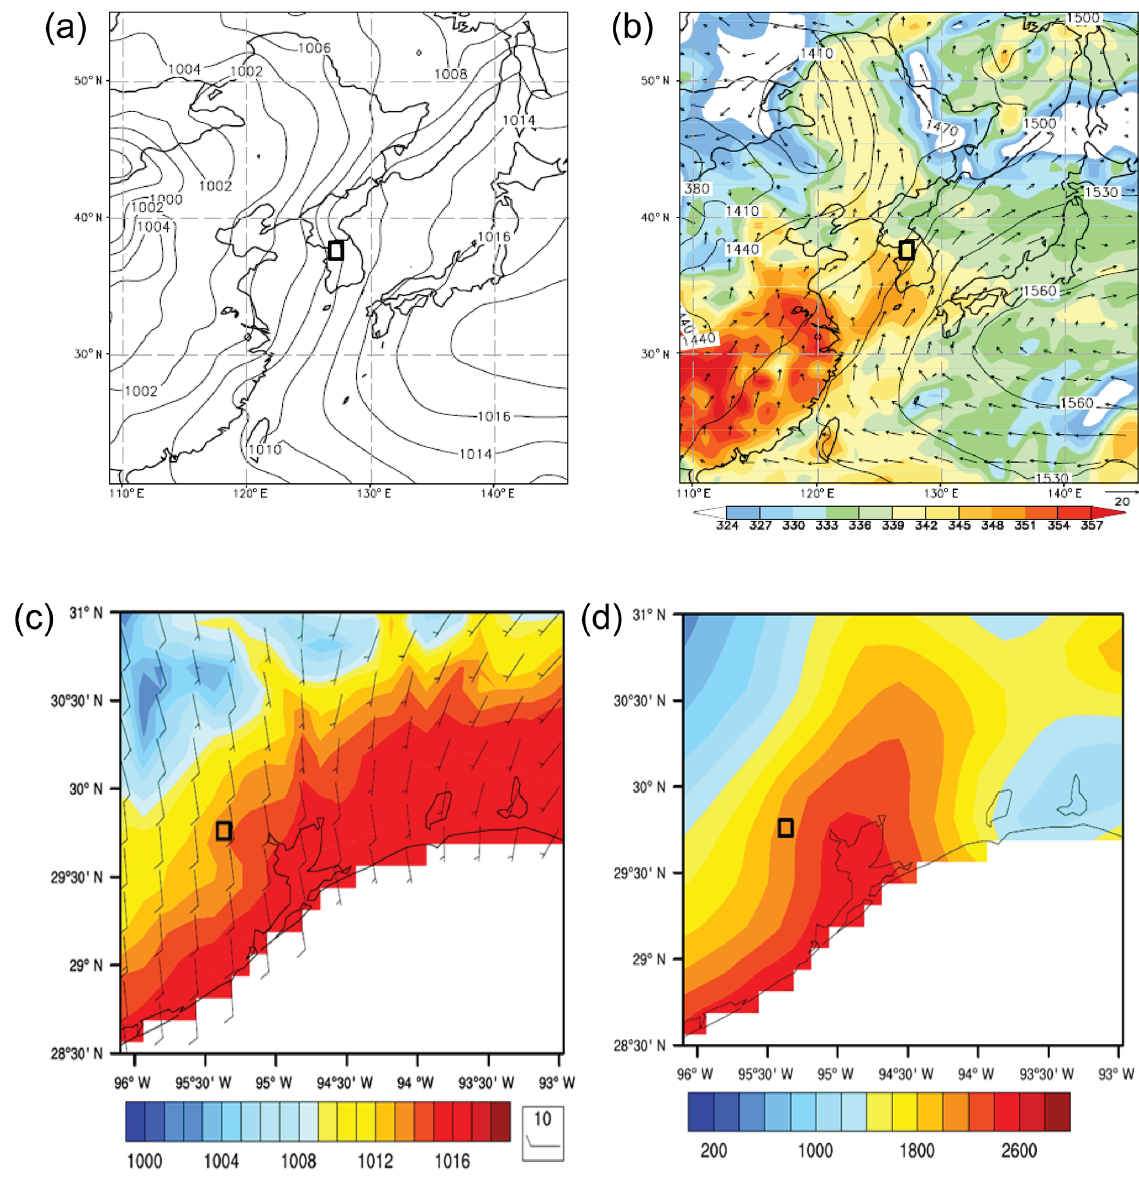
Figure 1. (a) Sea-level pressure (hPa) and (b) 850hPa wind (ms − 1 ; arrows) geopotential height (m; contours) and equivalent potential temperature (K; shaded) at 09:00LST on 26 July 2011 over northeast Asia. The rectangles in the Korean Peninsula in panels (a) and (b) mark the center of Seoul. (c) Sea-level pressure (hPa; shaded) and wind at 10ma . s . l . (ms − 1 ; barbs) and (d) convective available potential energy (Jkg − 1 ) at 05:00LST on 18 July 2013 in and around Houston. The rectangles in panels (c) and (d) mark the center of